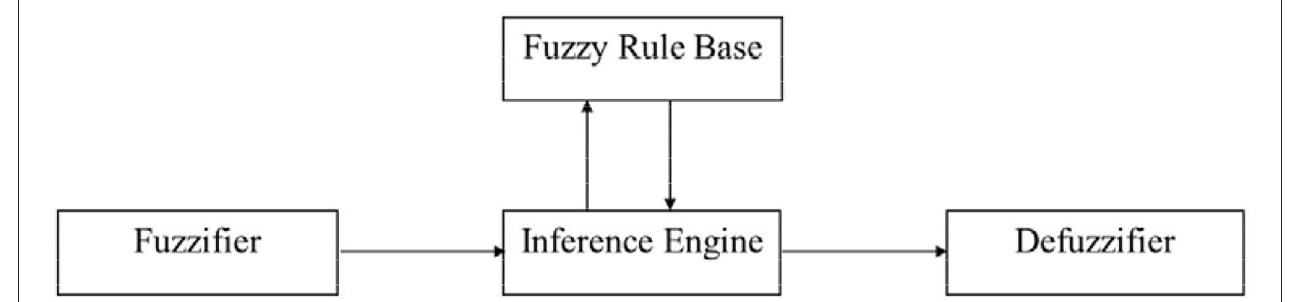
FIGURE 1 | Block diagram of fuzzy logic controller.